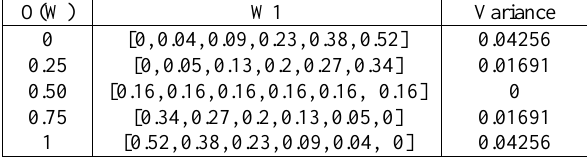
Table 5. Weight vector and variance for five different optimism degree